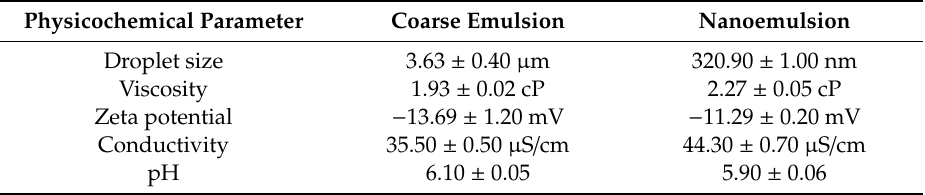
Physicochemical characterization of freshly prepared oil-in-water coarse and nanometric